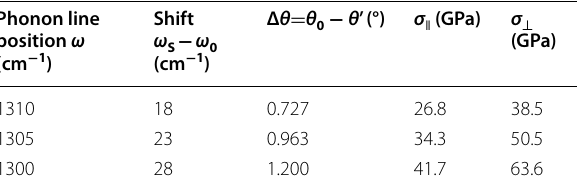
and σ calculated according to Raman ∥ ⟂